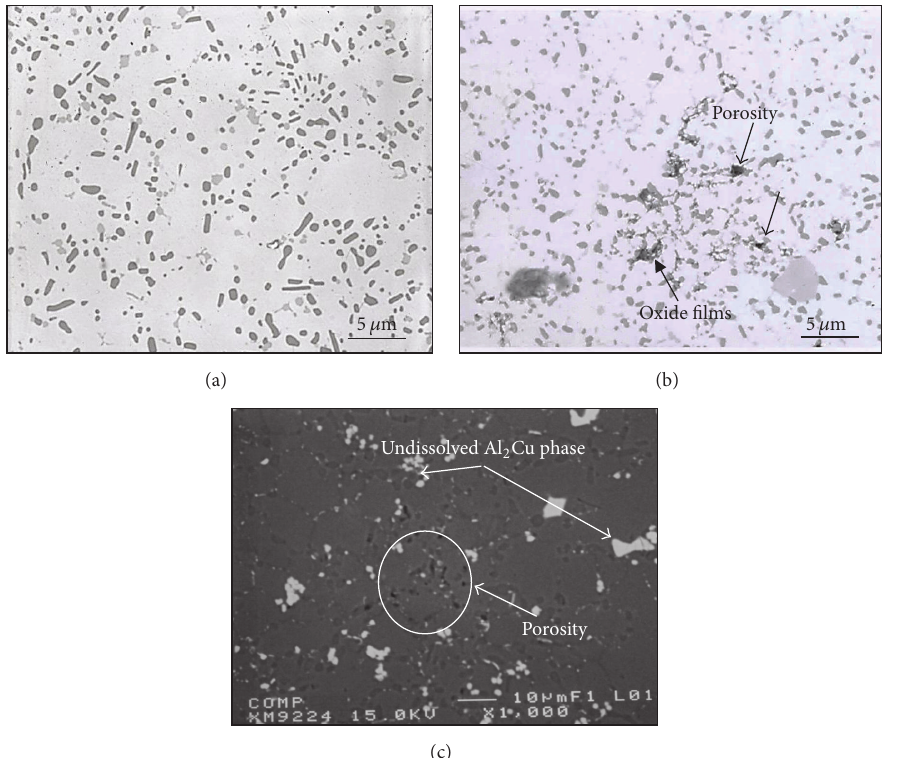
Figure 5: Microstructure of (a) 0.06 and (b and c) 0.55% Mg-containing alloys following SHT.